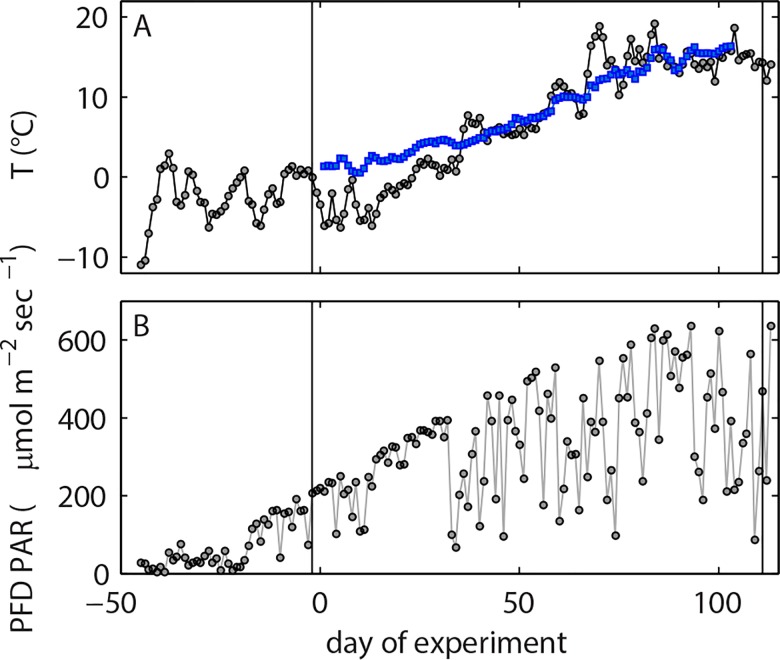
Daily averaged (A) air temperature (grey), surface water temperature (blue) and (B) photon flux density (PFD) of photosynthetic active radiation (PAR). Air temperature and PAR data were recorded on the roof of the Sven Lovén Centre (~3 km distance from the mesocosm deployment site) and downloaded from http://www.weather.loven.gu.se/kristineberg/data.shtml. Surface water temperature was recorded with HOBO pro v2 data logger mounted at 0.1 m depth in M2. Note that temperature development was quasi identical in all mesocosms (S3 Fig). The timeline starts with the arrival of research vessel Alkor at Gullmar Fjord on the 23rd of January, 2013 (t-45). Grey vertical lines indicate the start (7th of March; t-2) and the end (28th of June; t111) of the successful experiment.